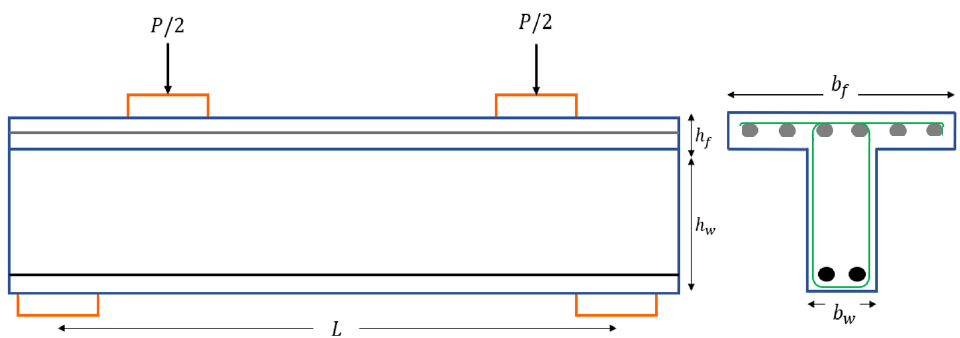
Figure 16. Typical Geometrical Characteristics of a T-Beam.